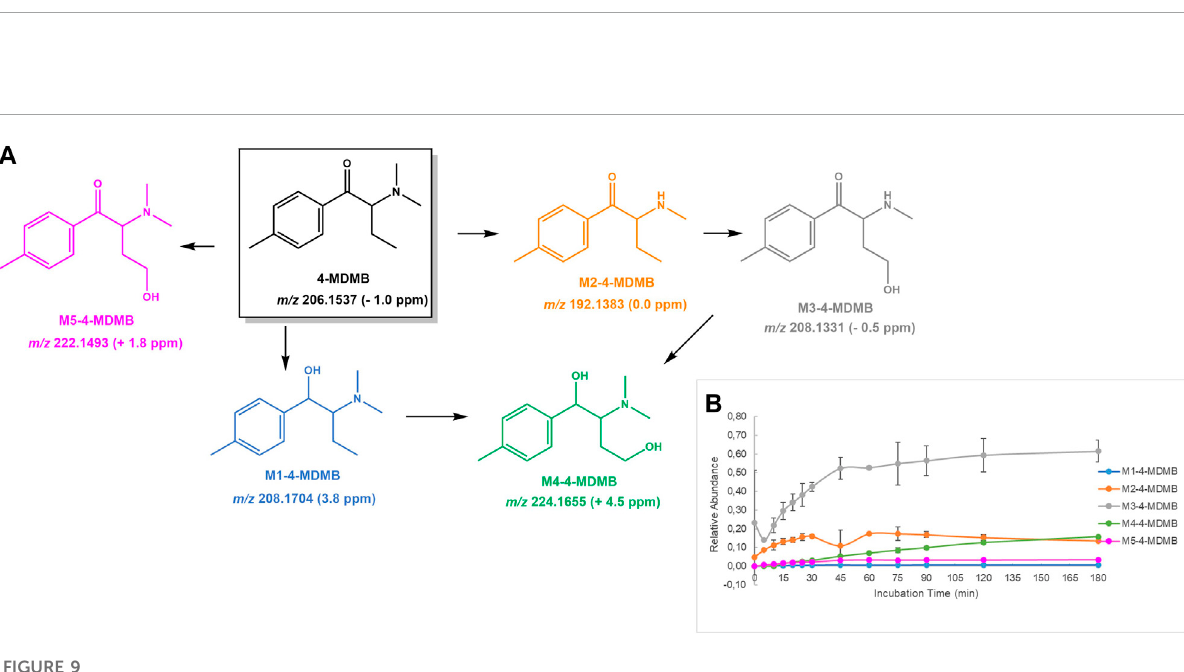
on the identi fi cation of the previously identi fi ed hydroxylated metabolites (we cannot exclude hydroxylation at the aromatic moiety). Non-etheless the N -methyl substituent cannot be discarded as the location of this metabolic transformation, based on the fragmentation pattern observed for